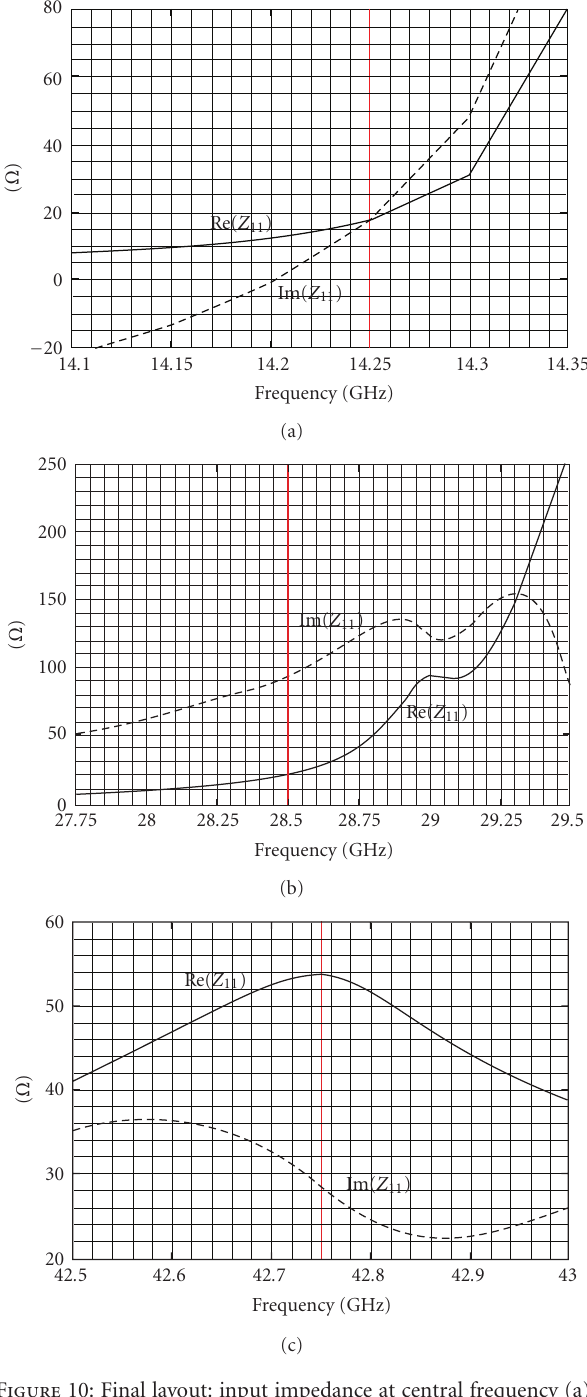
Figure 10: Final layout: input impedance at central frequency (a), at first harmonic (b), and at second harmonic